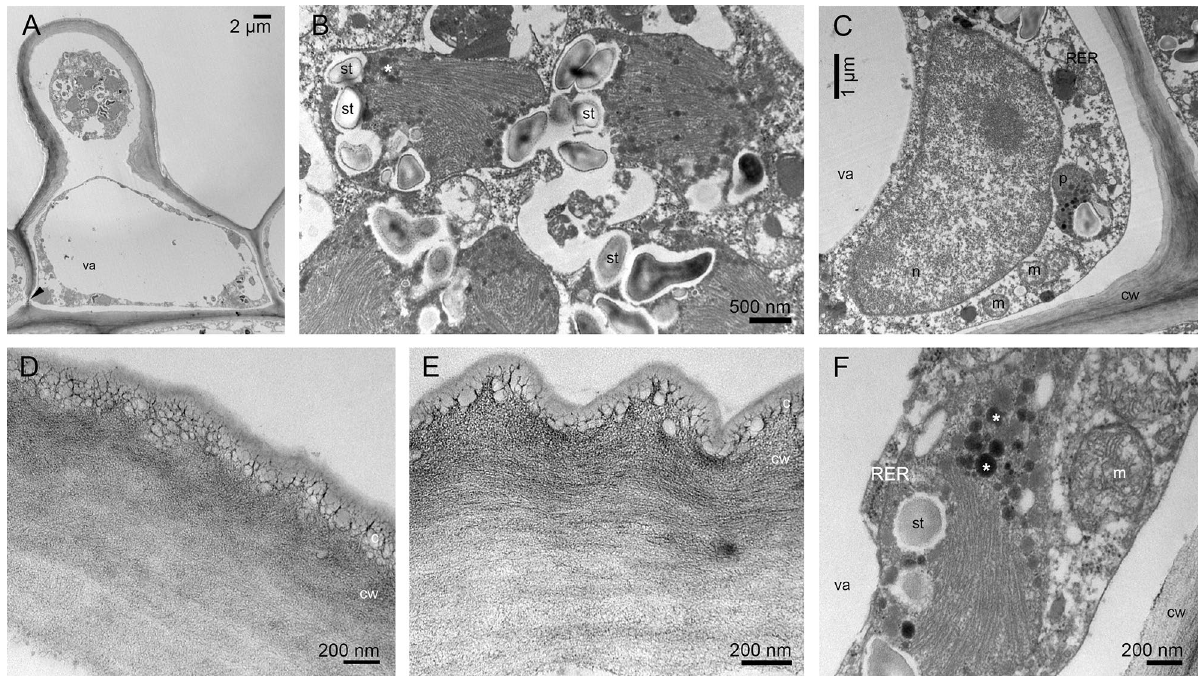
Figure 7. The bud: ( A ) Obpyriform papilla (TEM); ( B ) Details of ( A ) The apex of a papilla with plastids equipped with lamellae, starch grains and plastoglobuli; plasmodesmata ( arrow ) present in the cell wall (TEM); C. Details of ( A ) The bottom of the papilla with large nucleus, plastids, mitochondria, RER profiles (TEM); ( D ) Micro-channels visible in the cuticle of papillae (TEM); ( E ) Striate cuticle with reticulation on flat cells near the papilla, note remnants of secreted materials on cuticle (TEM); ( F ) Mitochondria, plastids with starch grains and plastoglobuli ( asterisks ), RER profiles in the flat cell (TEM). c —cuticle; cw —cell wall; m —mitochondrion; n —